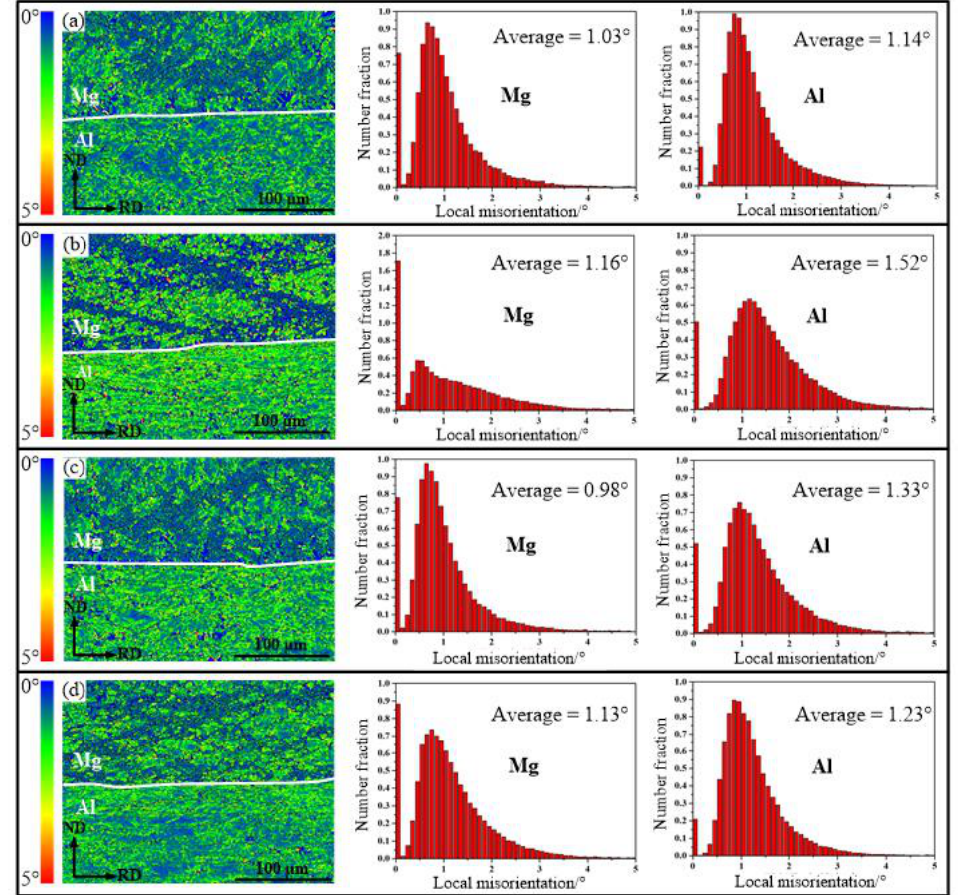
Figure 10. KAM maps and corresponding distributions of the corrugated clad sheet: ( a ) front waist; ( b ) peak; ( c ) back waist; ( d ) trough.